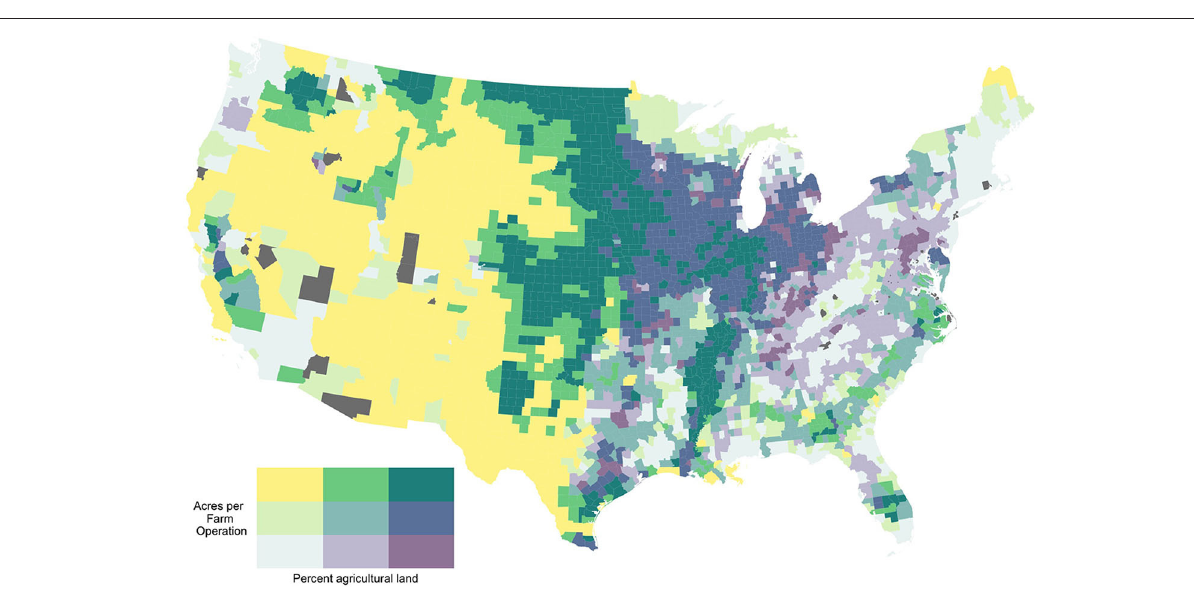
FIGURE 7 | Bivariate choropleth constructed by binning county-level average farm size (by acre per operation per county) and percent agricultural land by county (both pasture and crop production) into thirds and pairing each tercile into distinct categories. Yellow indicates counties with large average farm sizes (in acres/operation) and a low percentage of agricultural land. Teal indicates counties with large average farm sizes and a high percentage of agricultural land. Purple indicates counties with a small average farm size but a large percentage of the county as agricultural land. Light blue is both low percentage agricultural land and a small average farm size per county. Dark gray counties indicate missing data. Data: NWALT and USDA NASS Census of